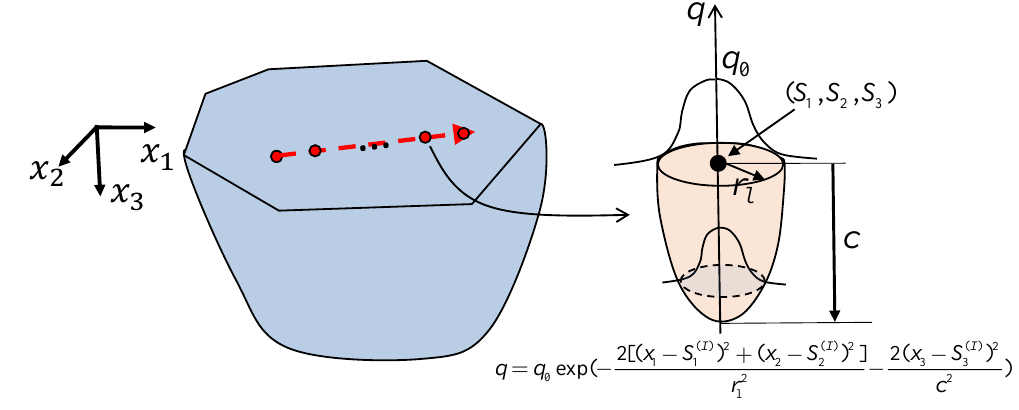
Figure 3. The discretized heat source is modeled as a half-ellipsoidal volumetric